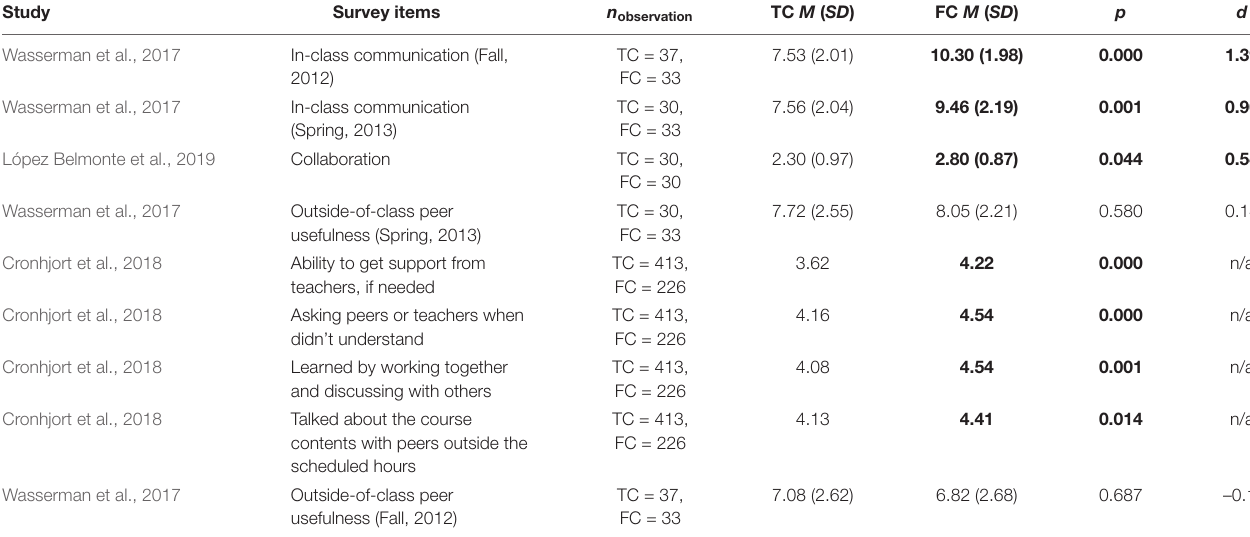
TABLE 1 | Survey results: Interaction by effect size.